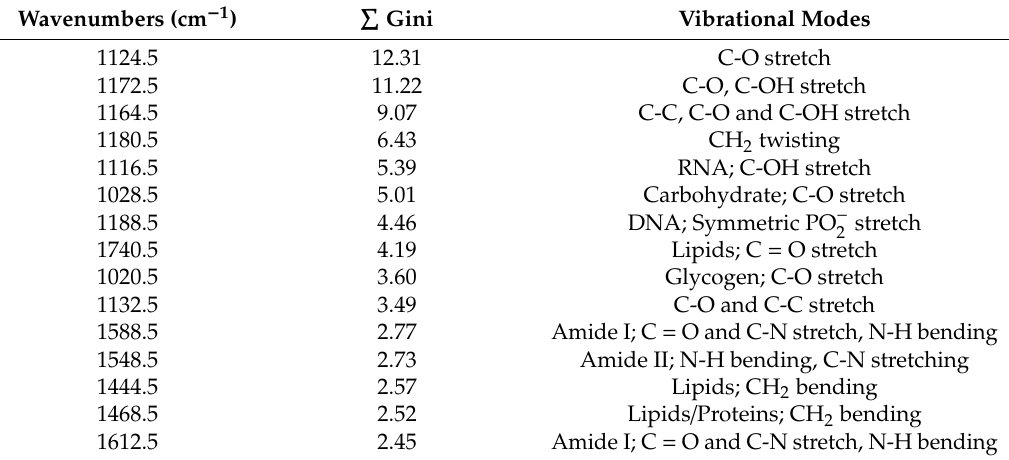
Table 6. The top 15 wavenumbers from the < 3 kDa serum filtrate (1800–800 cm − 1 ) random forest classification between IDH1 -mutated and IDH1 -wildtype with associated vibrational modes [27].